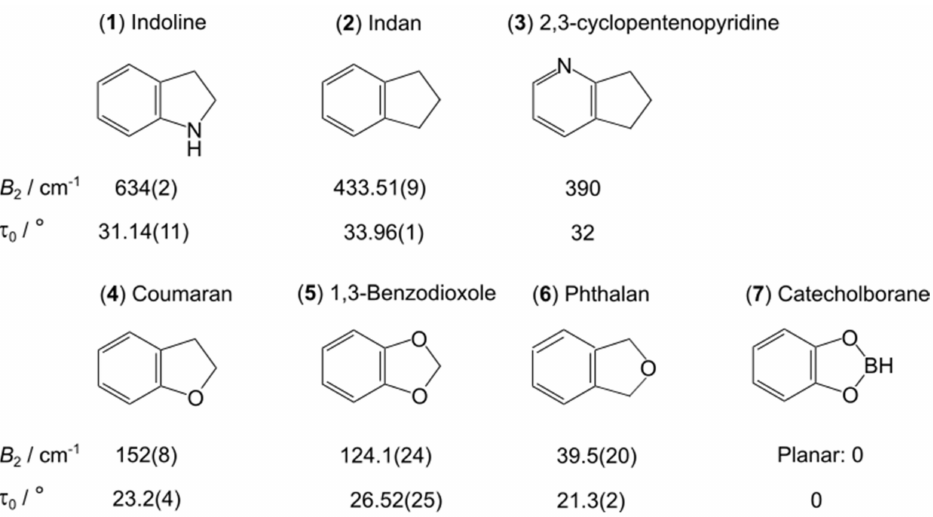
Figure 24. Molecules fused by an aromatic six-membered ring with an unsaturated five-membered ring with a ring-puckering motion. ( 1 ) Indoline [220], ( 2 ) indan [218], ( 3 ) 2,3-cyclopentenopyridine [221], ( 4 ) coumaran [222], ( 5 ) 1,3-benzodioxole [223], ( 6 ) phthalan [224], and for comparison the planar